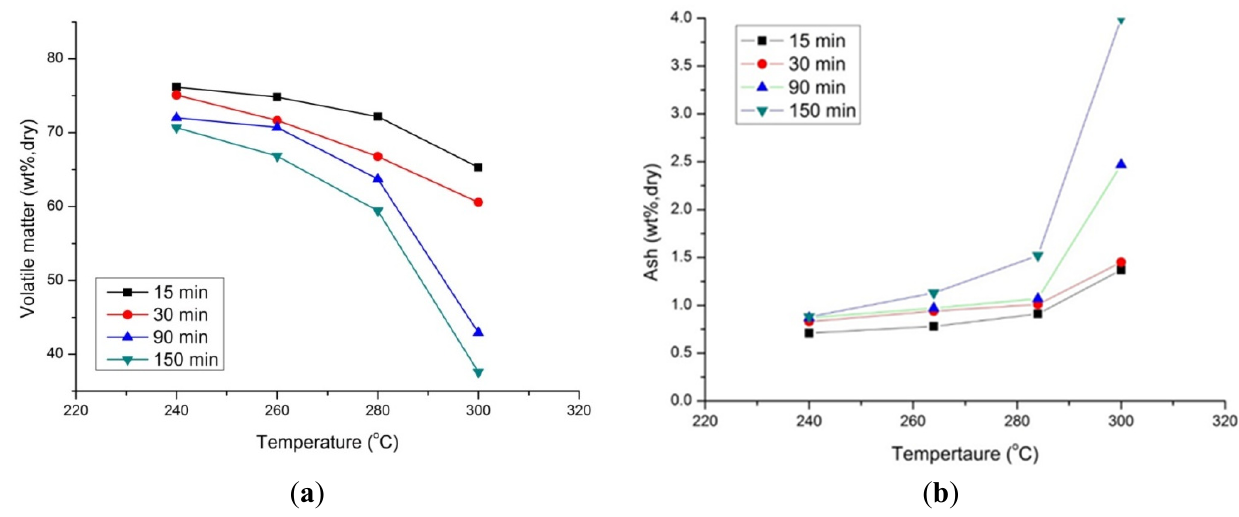
Figure 5. ( a ) Volatile matter profile of torrefied beech wood with torrefaction temperature at various residence times VM—raw beech wood (77.9 wt%, db) ; ( b ) ash profile